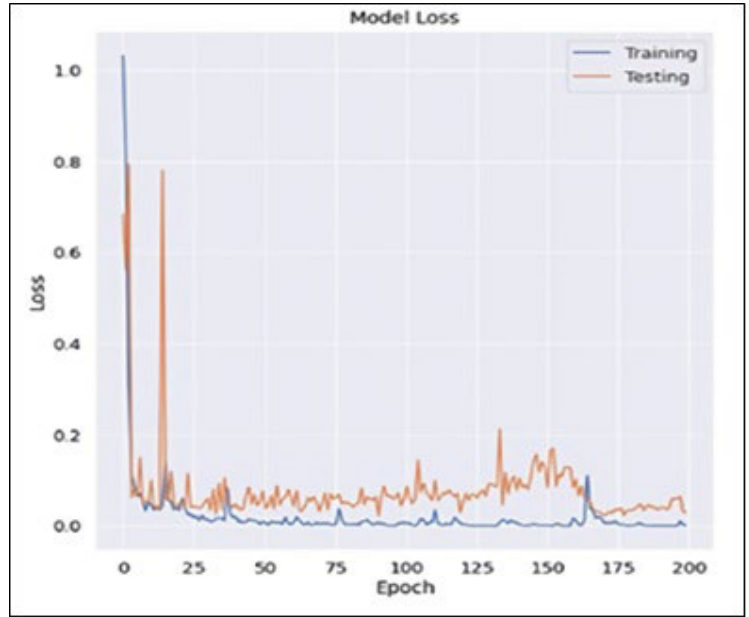
Figure 14. Model loss. Table 8. The performance of MULTforAD in comparison with